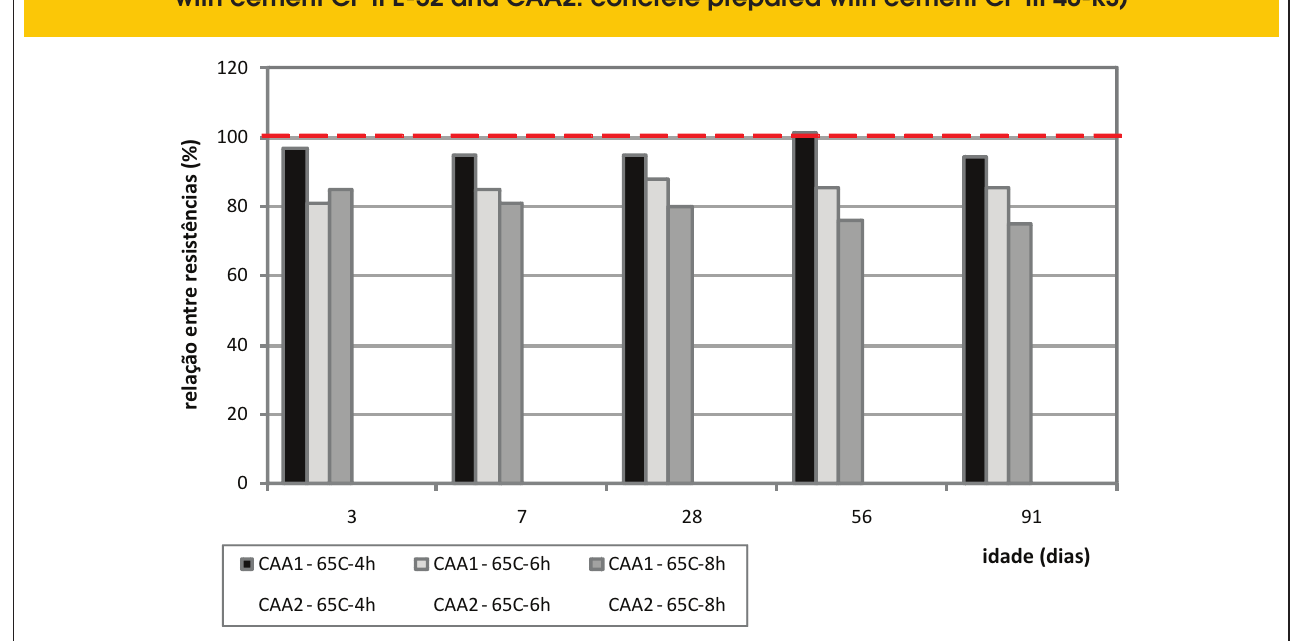
Figure 4 – Comparative analysis between the concretes studied (CAA1: concrete prepared with cement CP II E-32 and CAA2: concrete prepared with cement CP III